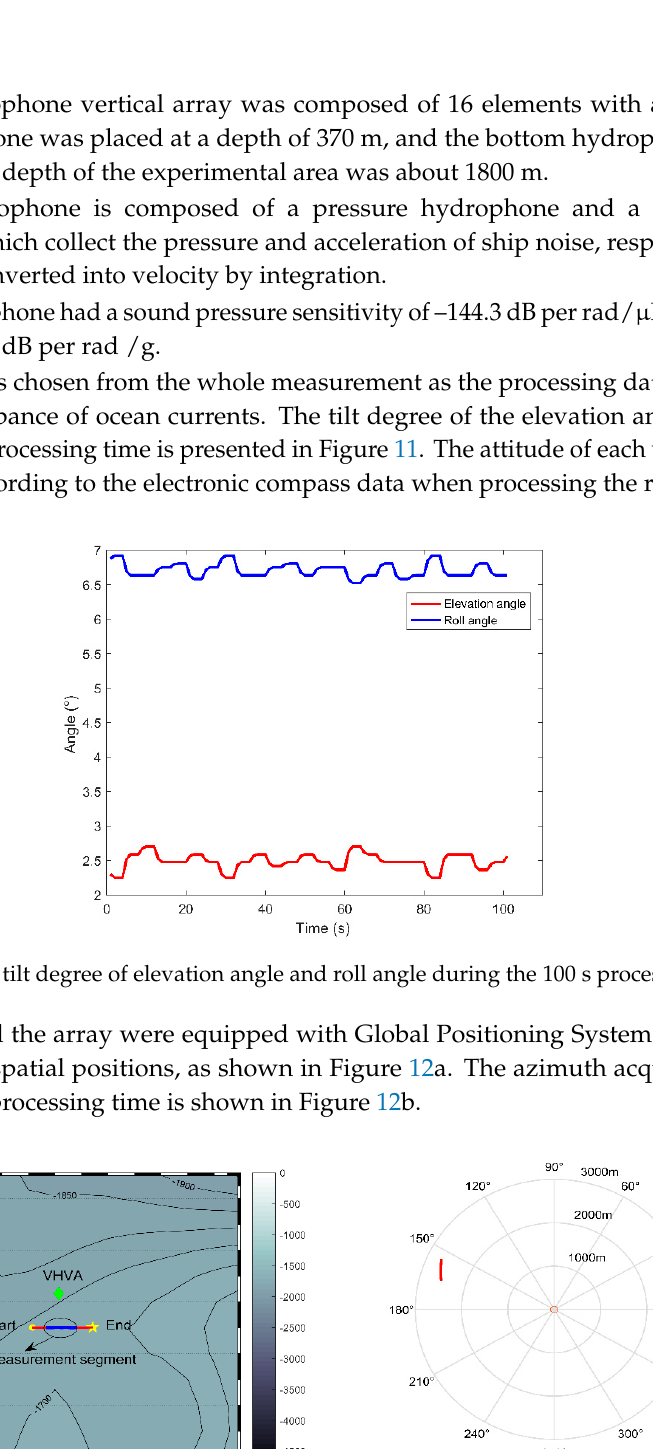
Figure 12. Information obtained by GPS data. ( a ) Ship trajectory map (the green diamond represents the location of vector hydrophone vertical array; the yellow circle and the five-pointed star stand for the starting and ending positions of the trace, respectively; and the solid red line is the trajectory and the solid blue line in the middle is that of the intercepted measurement segment); ( b ) azimuth change obtained by GPS data (the solid red line represents azimuth change during the intercepted measurement segment).